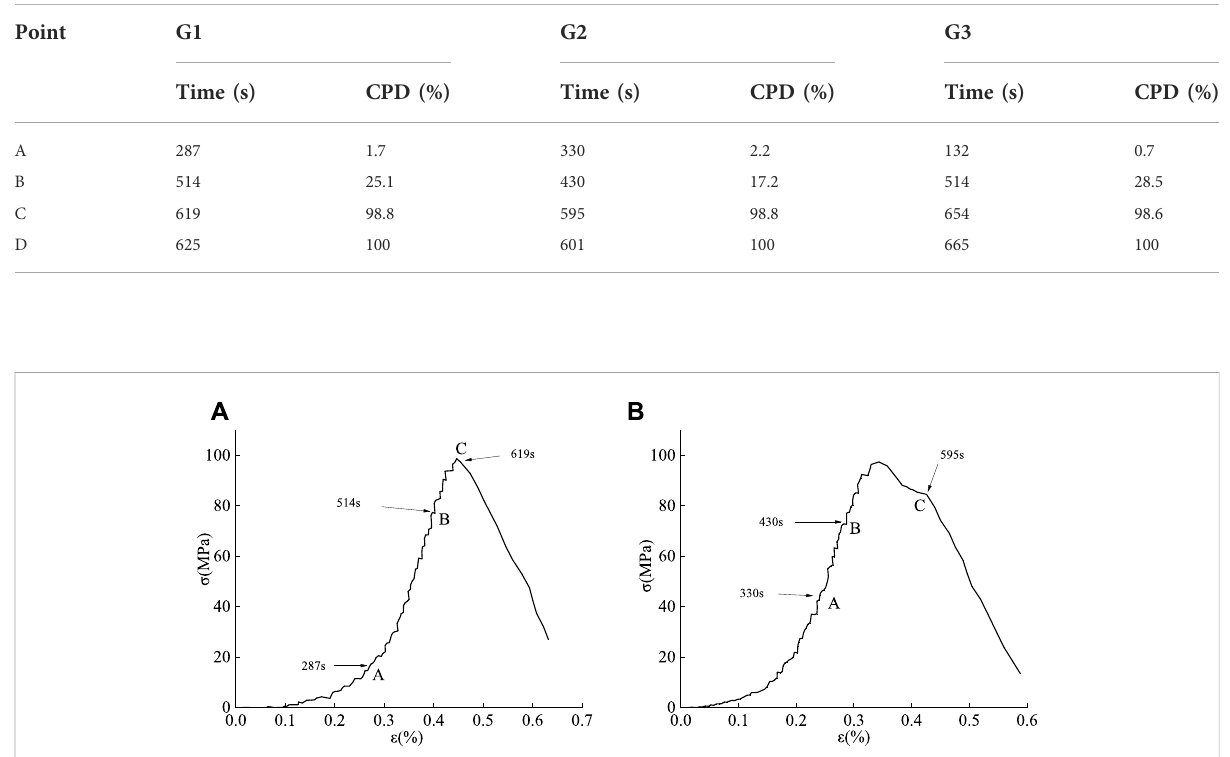
TABLE 3 The times and CPD values corresponding to the ends of the different stages in specimens G1 – G3.